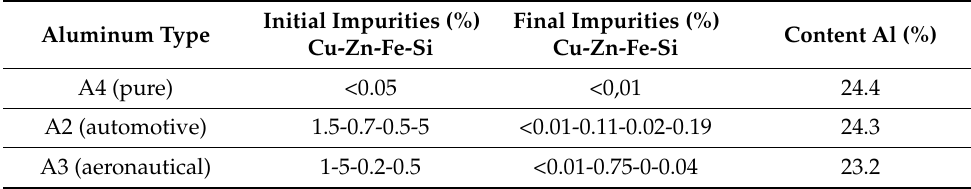
Table 9. Analysis of the purity of aluminum oxide obtained.